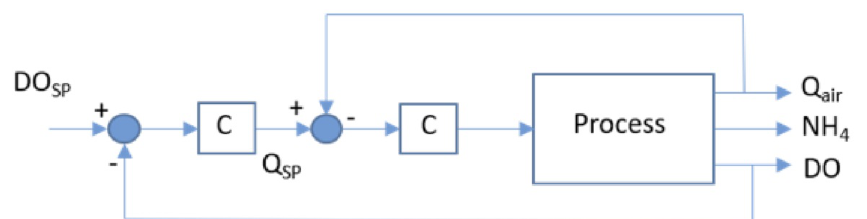
Figure 2. PI cascade control structure.